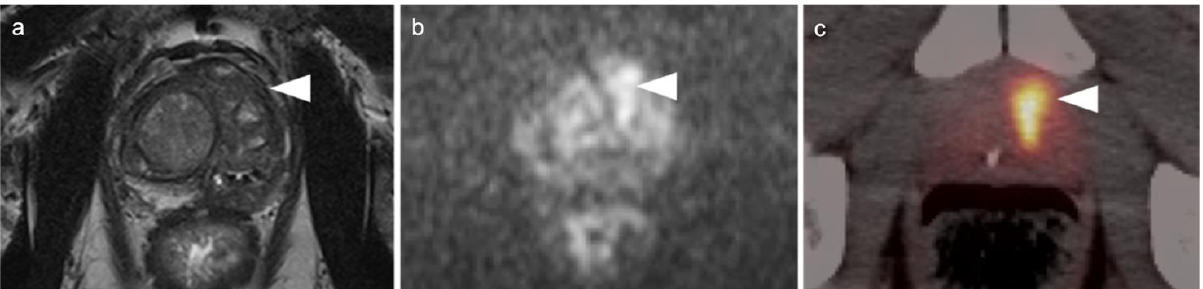
Figure 24. Prostate cancer in a patient with benign prostatic hypertrophy (BPH), compared by multiparametric (mp) MRI ( a , b ) and [ 18 F]-DCFPyL PET-CT ( c ). ( a ) T2 MRI fails to clearly delineate the prostate cancer (site shown by white arrowhead) with the background of benign prostatic hypertrophy (PBH) nodules; ( b ) DWI MRI shows high signal intensity due to prostate cancer (white arrowhead); ( c ) the prostate cancer is best shown on the [ 18 F]-DCFPyL PET-CT (white arrowhead). The